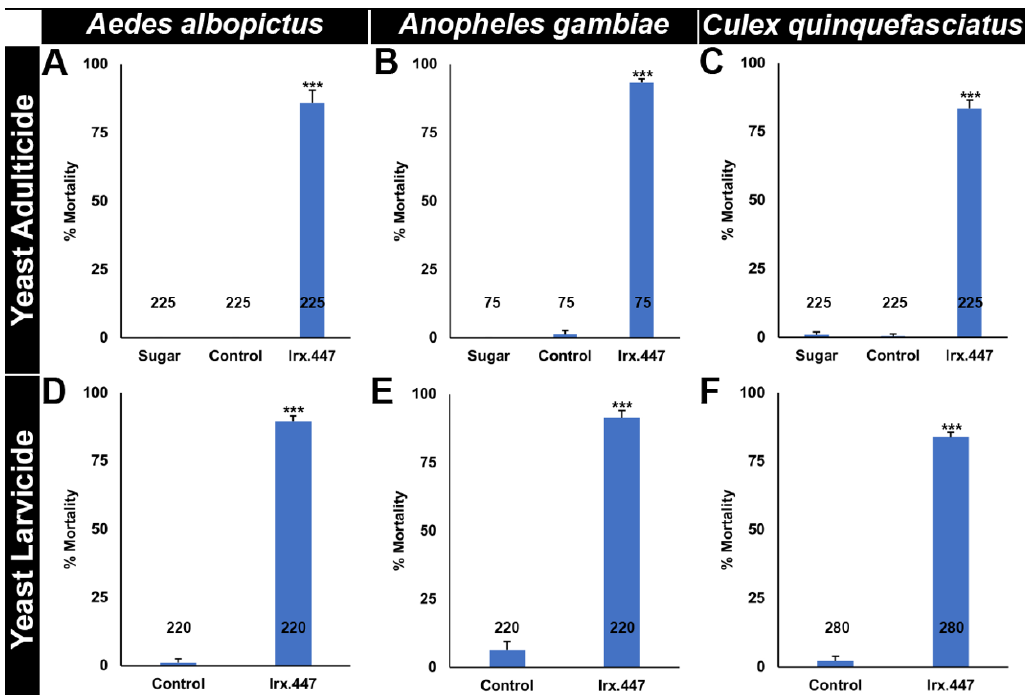
Figure 3. Irx.447 yeast is a broad-based insecticide. Oral consumption of dried inactivated Irx.447 yeast by larvae ( A – C ) or by adult females as an ATSB ( D – F ) induces significant mortality rates in A. albopictus ( A , C ), A. gambiae ( B , D ), and C. quinquefasciatus ( C , F ). Throughout the figure, data are shown as mean mortalities; error bars denote SEMs; n numbers are found below each bar in the graphs. Data were evaluated with the Student’s t-test ( A – C ) or with ANOVA ( D – F ); *** p < 0.001 vs. control.